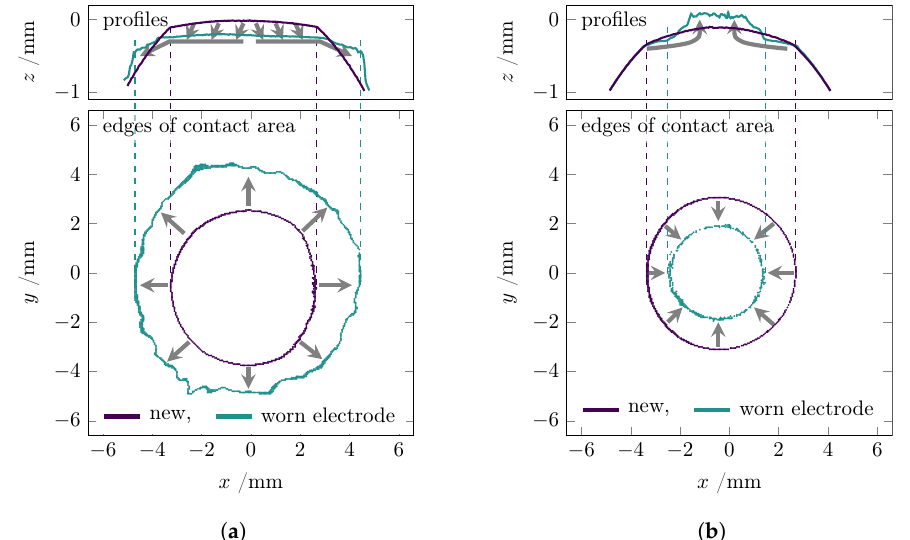
Figure 3. Typical modes of electrode wear and their mechanisms indicated by arrows at RSW of coated steel alloys: ( a ) mushrooming due to radial material flow and ( b ) plateau formation due to axial material